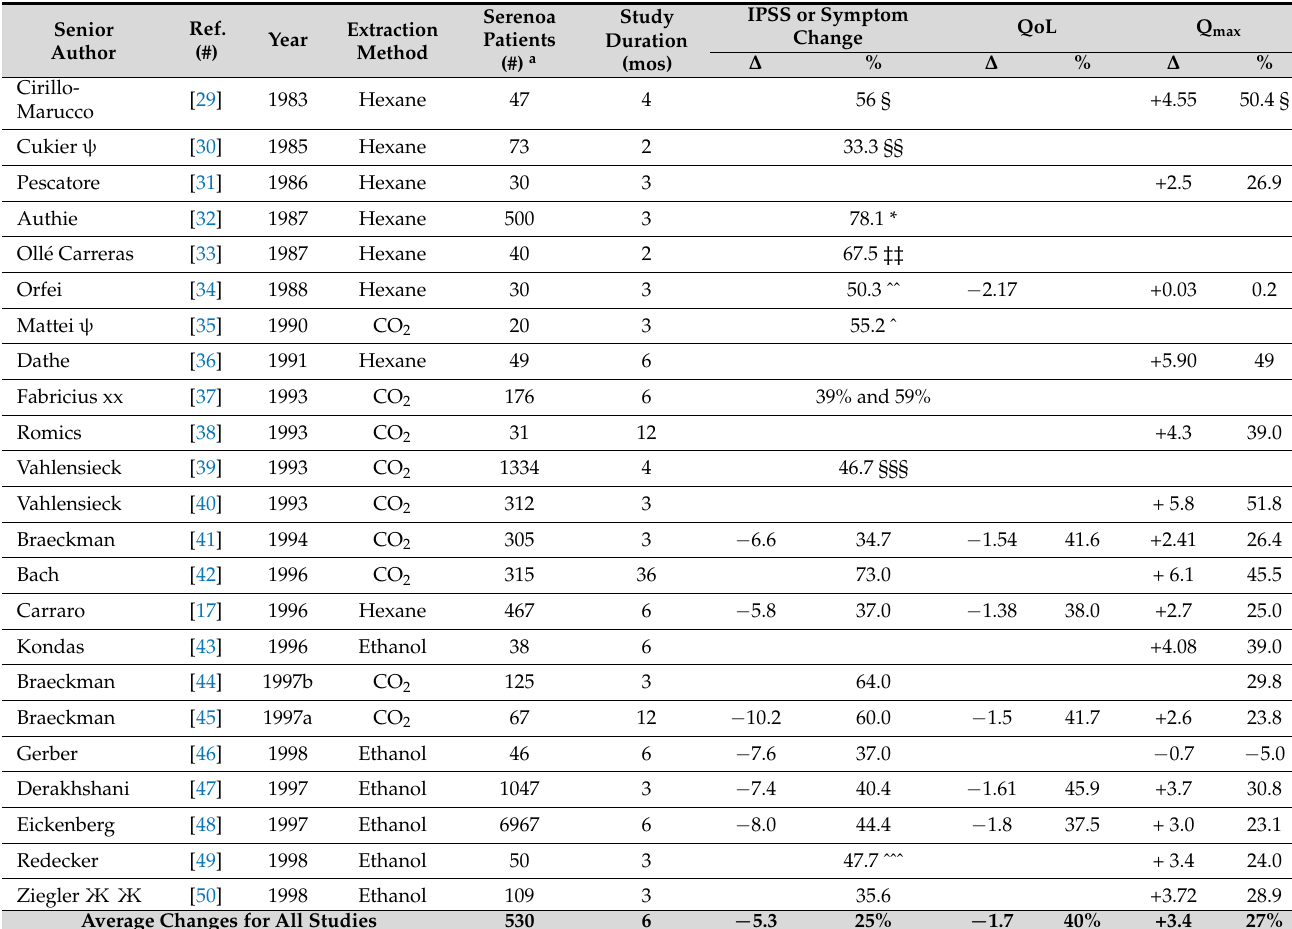
Table 1. Twenty-three studies cited in ESCOP 2003 met eligibility for LSESr